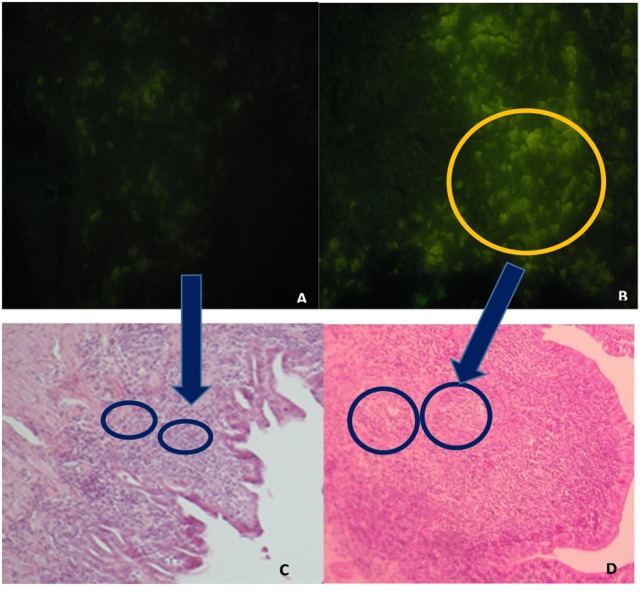
Peyer’s patches microphotography, with marked (abundant) lymphocyte production in intestinal histological sections in the F4 group and control group. (A) Immunofluorescence image, stained with the B lymphocyte surface antigen AV20-FitC control group. Magnification: 400×. (B) Immunofluorescence image, stained with the B lymphocyte surface antigen AV20-FitC. F4 group. Into circle highlight a completely activated germinal center. Magnification: 400× (C) Peyer’s patches of control group hens, stained with hematoxylin-eosin. Magnification: 100×. (D) Peyer’s patches of F4 group hens, stained with hematoxylin-eosin. Magnification: 100×.